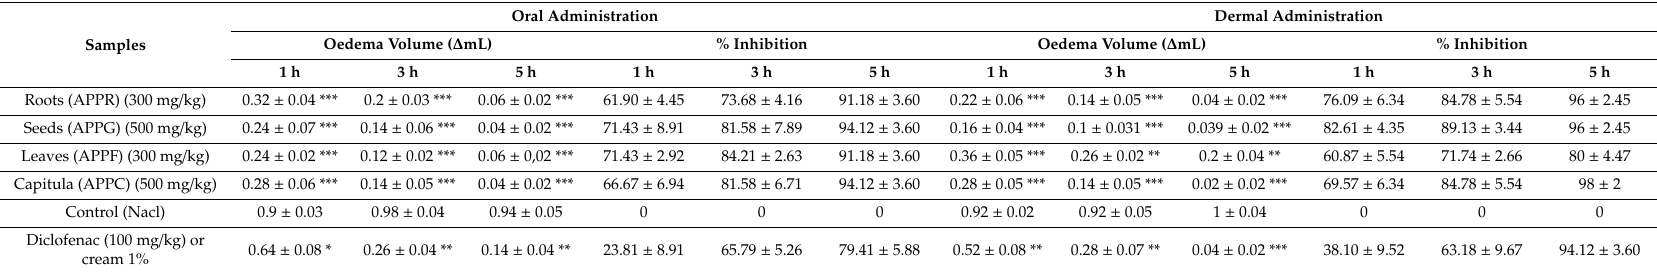
Table 3. Anti-inflammatory activity of di ff erent parts of A. pyrethrum (L) and the e ff ect of diclofenac by oral and dermal administration on carrageenan-induced paw edema in rats.